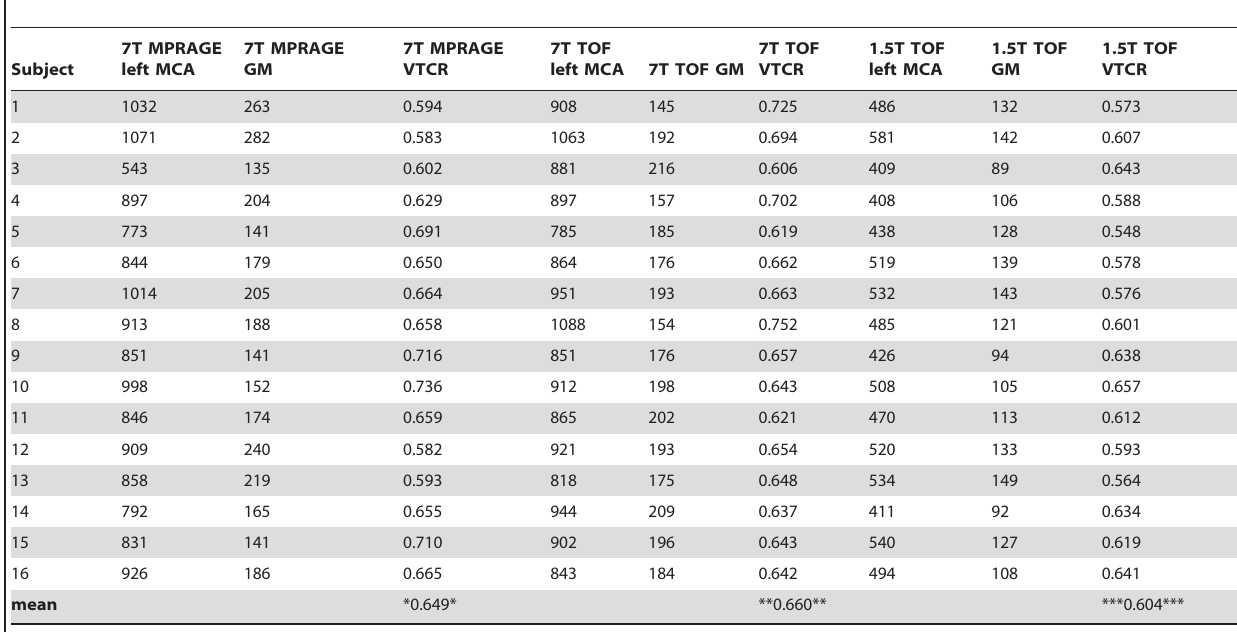
Table 6. Combined readings of both raters for signal intensities of left middle cerebral artery, adjacent gray matter and calculated vessel-tissue contrast ratio for all